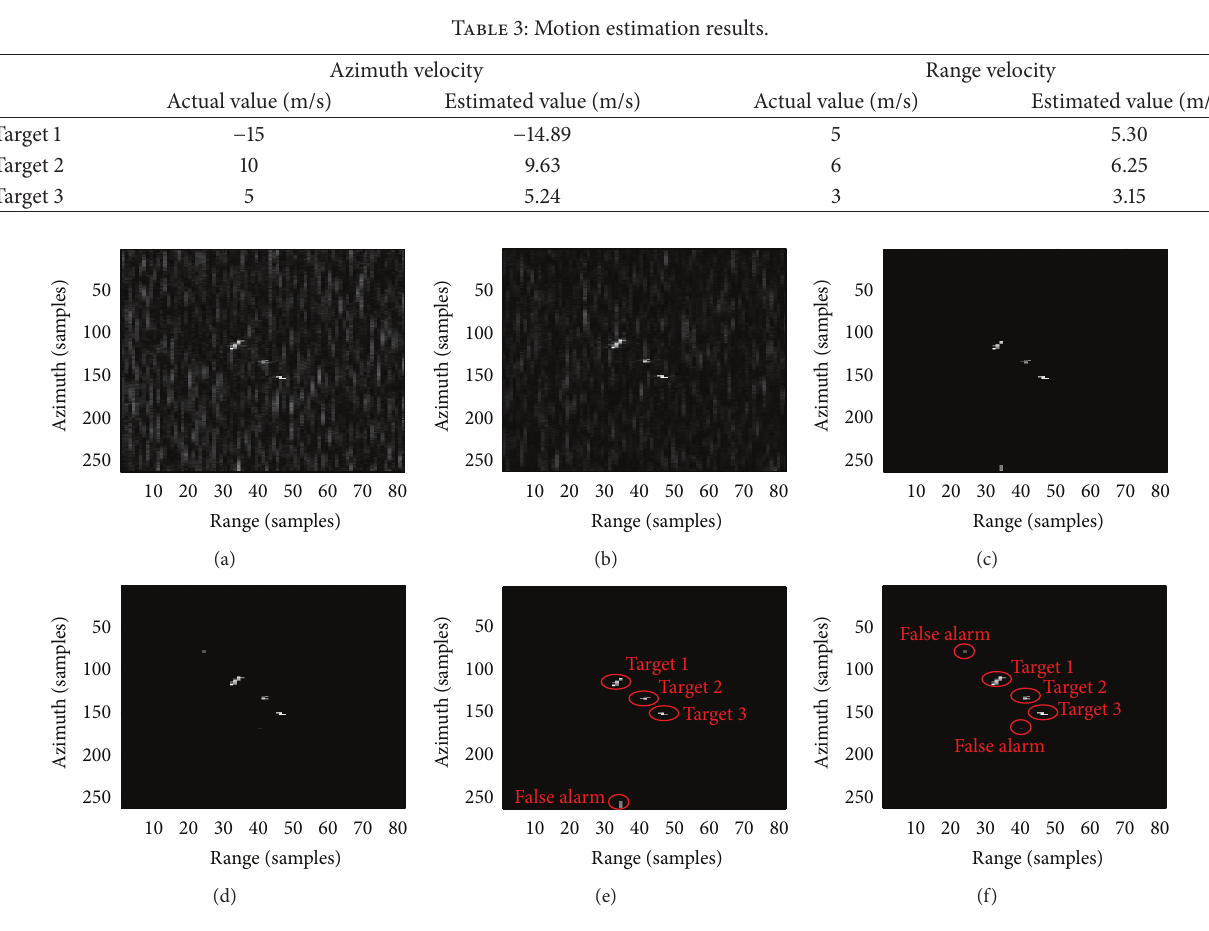
Figure 11: The simulation